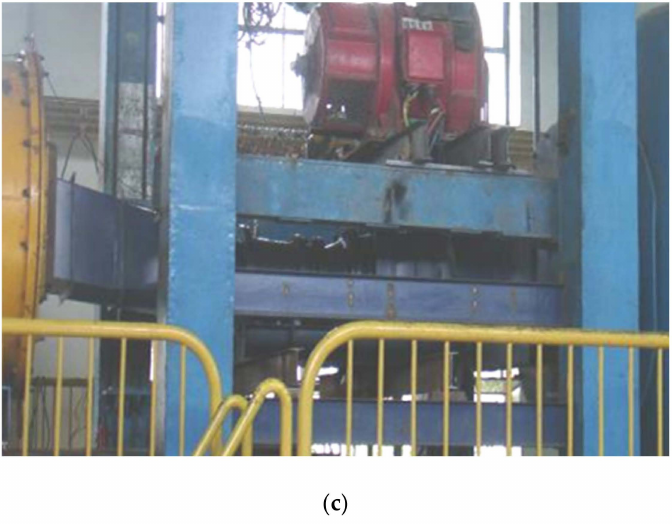
Figure 5. Physical diagrams of experiment: ( a ) impeller; ( b ) guide vane; ( c ) pump device.